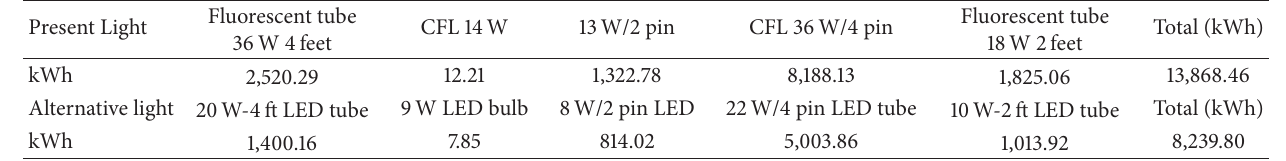
Table 4: Energy consumption between present and alternative light per day.